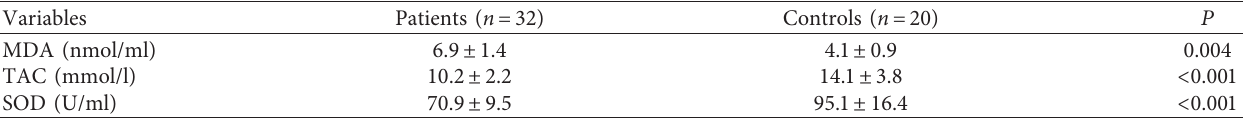
Table 2: Oxidative status markers in patients with autoimmune thyroiditis and healthy controls.